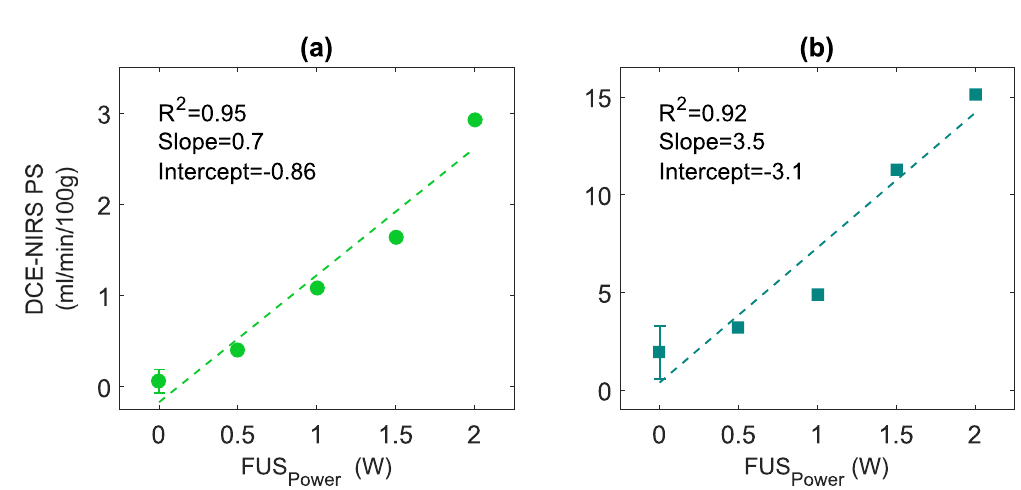
Figure 3. Permeability surface-area (PS) values obtained for ICG and ( b ) for IRDye at different sonication powers. Higher leakage of IRDye reflects its smaller size, resulting in increasing permeability. The error bars at FUS Power = 0 W represent the standard deviation of PS values measured before sonication (N =